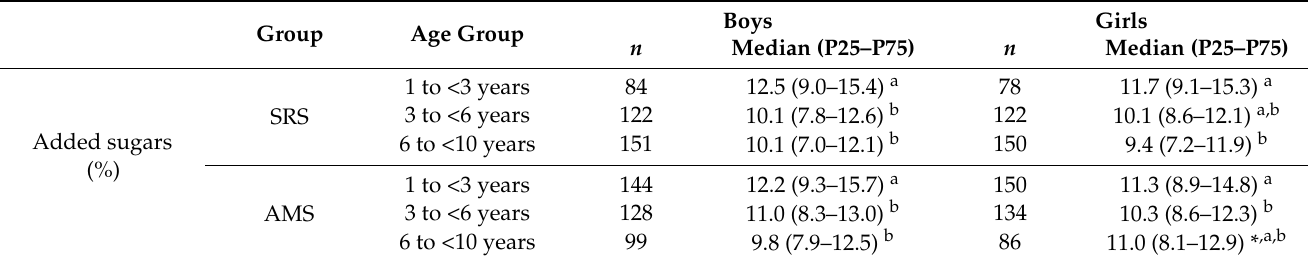
Table 2. Added sugar distribution as a percentage of total energy (%) in the Spanish Pediatric Population (EsNuPI) study.